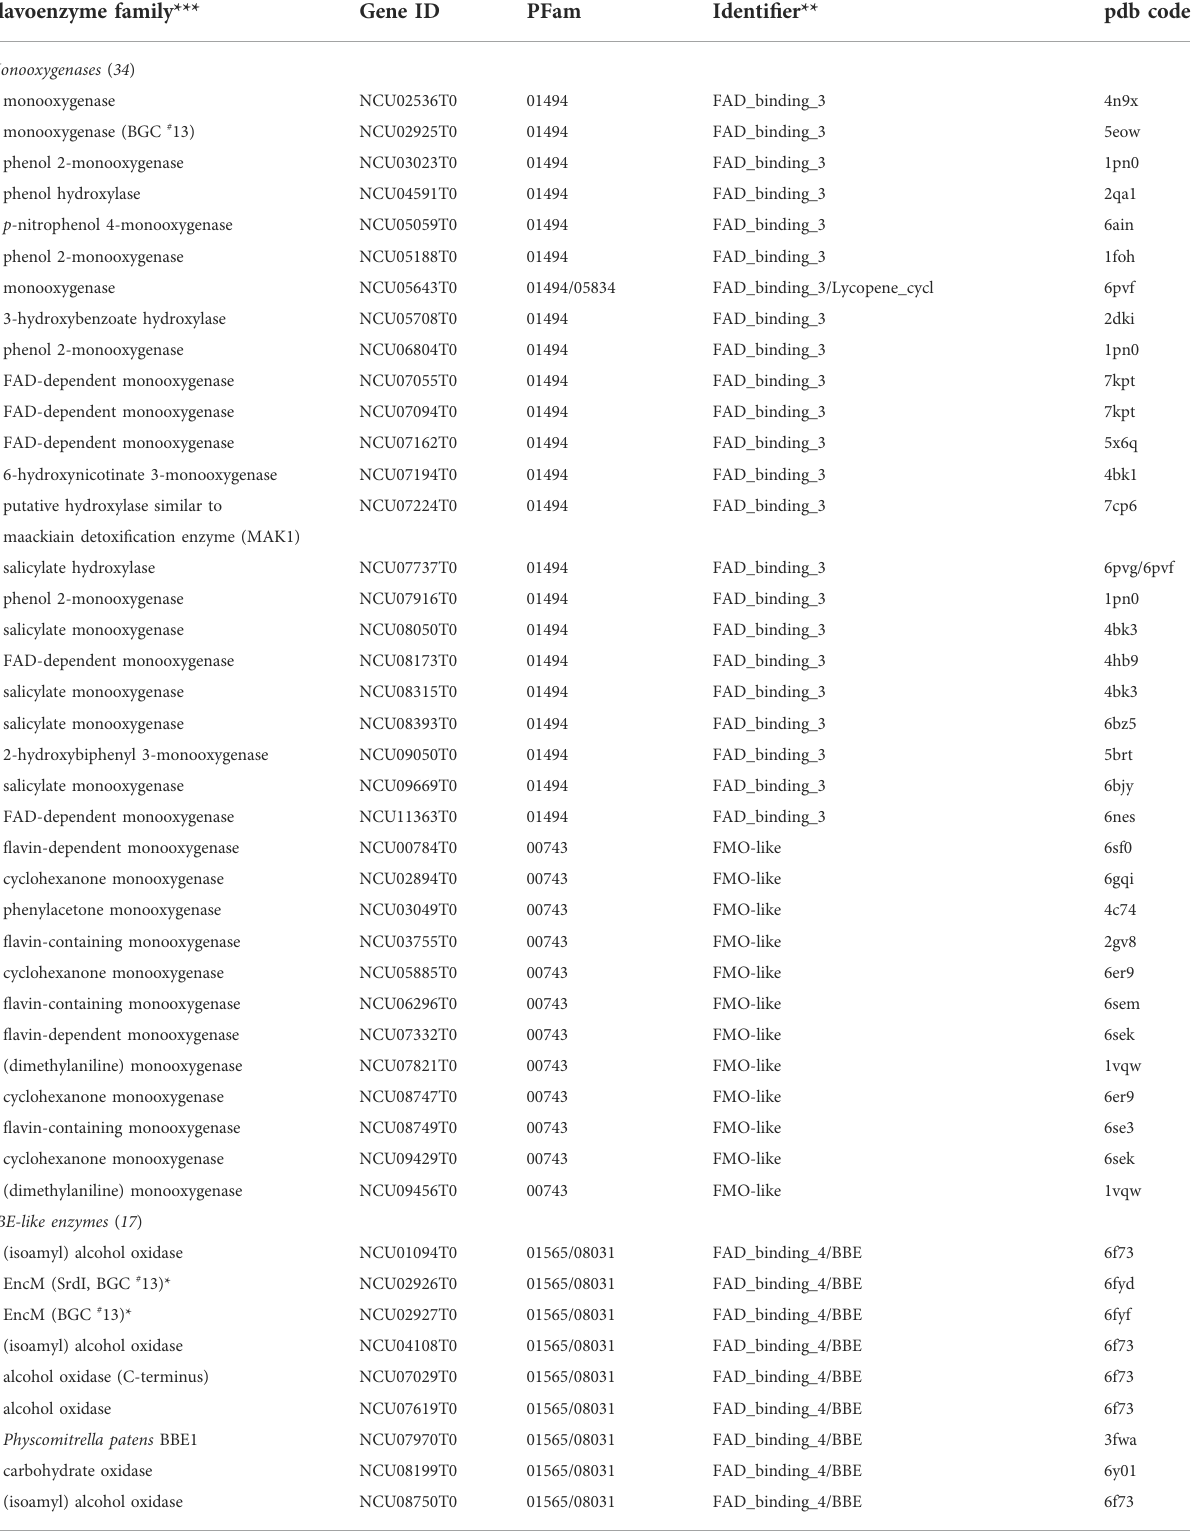
TABLE 2 The accessory fl avoproteome of N. crassa. The Table comprises fl avoenzymes potentially involved in secondary metabolism (for example encoded in biosynthetic gene clusters) or catalyzing unidenti fi ed reactions. The PDB codes indicate the closest structural